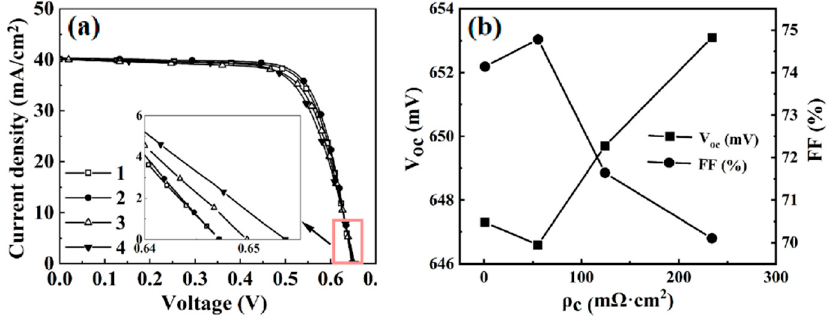
Figure 9. ( a ) J-V curves of four p-type Si solar cells fabricated with the four different types of Al pastes; ( b ) dependence of the fill factor and the open-circuit voltage on the contact resistivity.